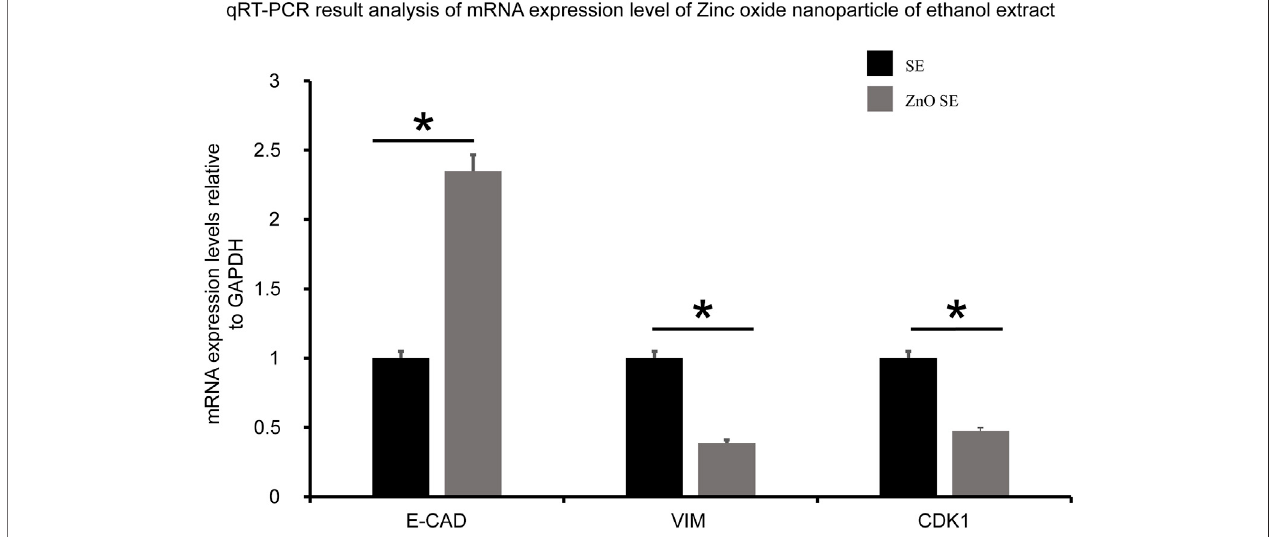
FIGURE 9 | Quantitative real-time PCR (qRT-PCR) analysis. The expression level of CDK1 and vimentin in Caco-2 cell lines treated with ZnO SE reduced by 0.525 and 0.62-fold, respectively (with p -Value (cid:2) 0.013 and 0.041), whereas the expression level of E-cadherin increased 2.35-fold ( p -Value (cid:2) 0.049) as compared to cells treated with